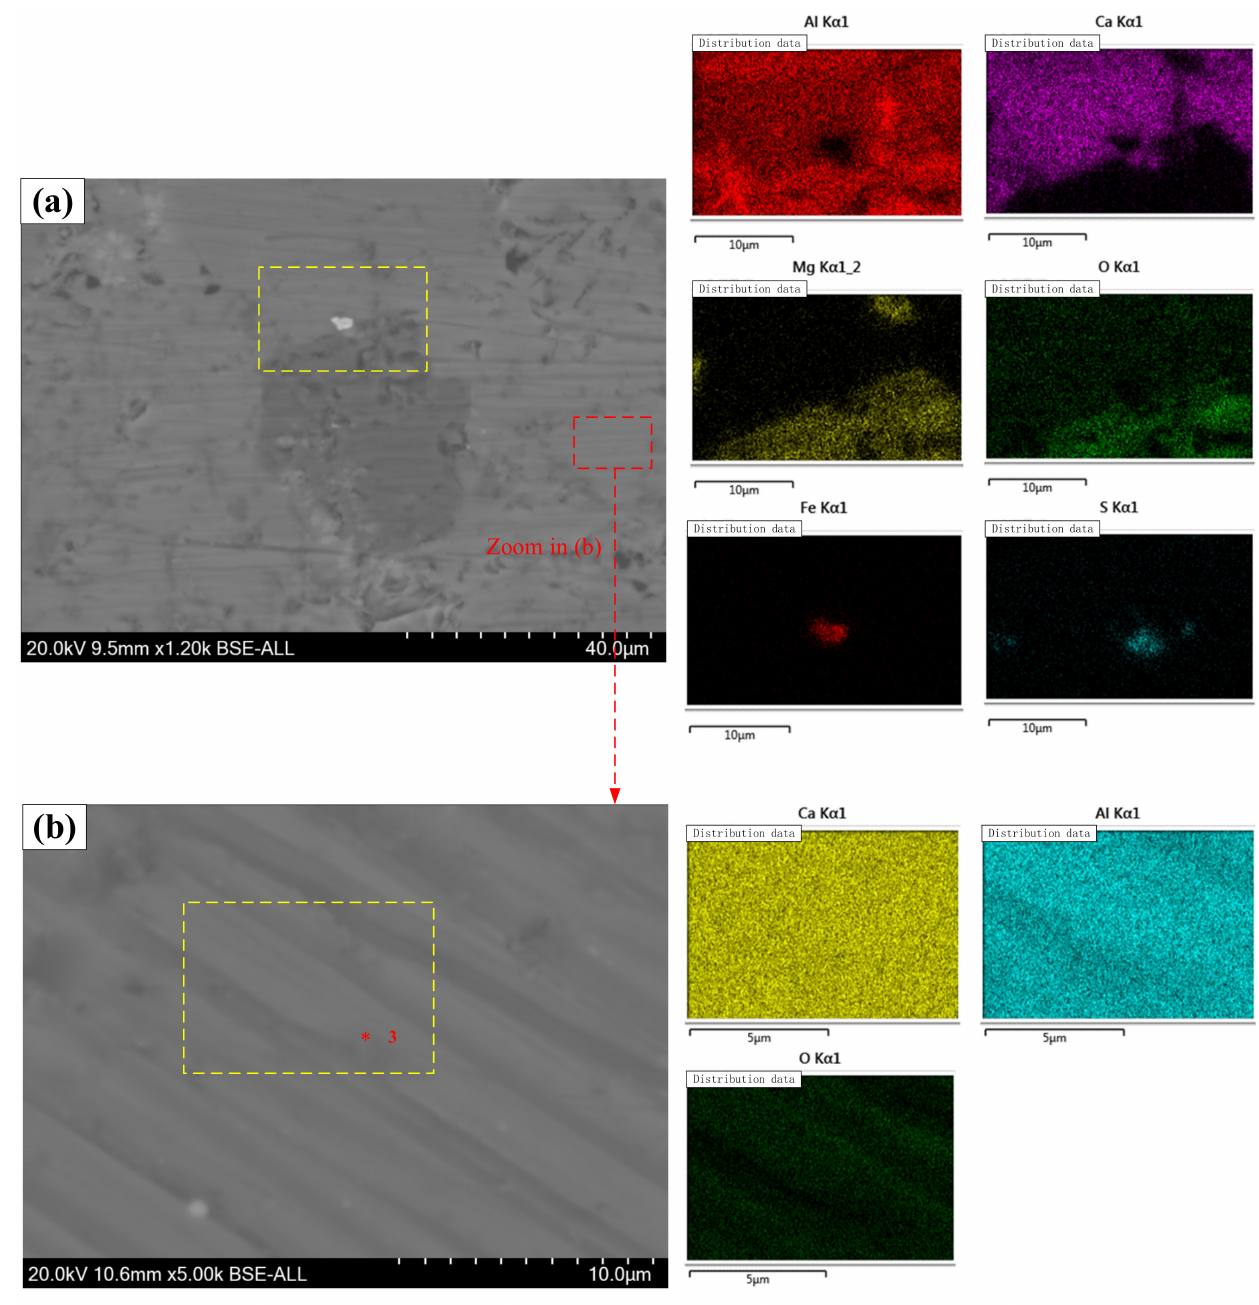
Figure 10. BSE micrographs of premelted calcium aluminate slag, ( a ) typical phases in slag, ( b ) enlarged view of the 11CaO · 7Al 2 O 3 · CaF 2